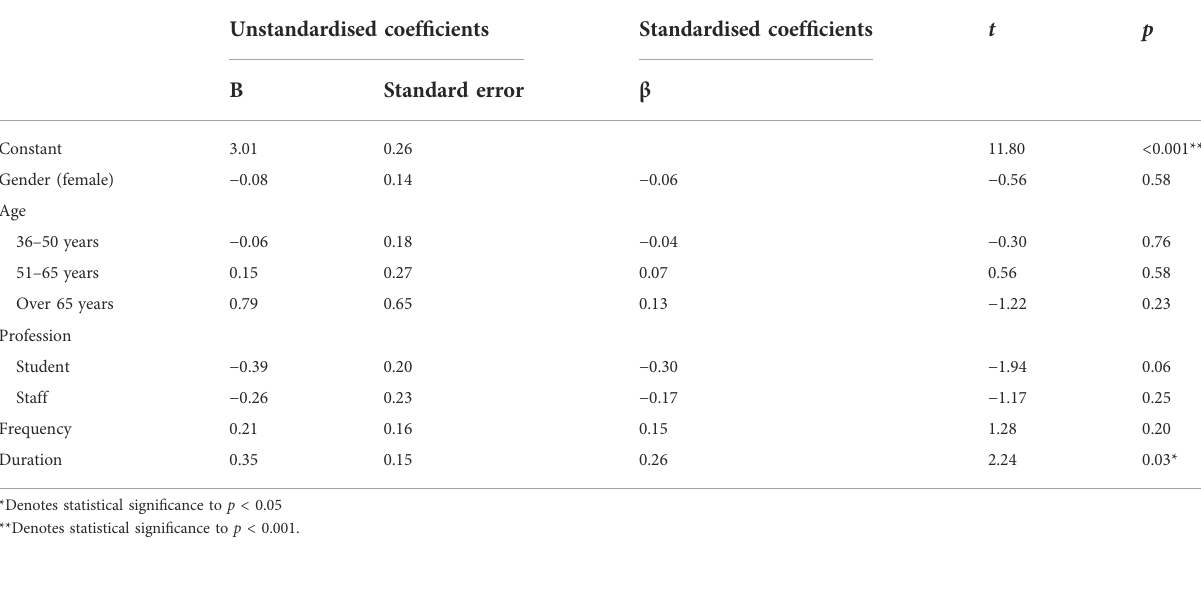
TABLE 5 Multiple Linear regression model for social wellbeing.